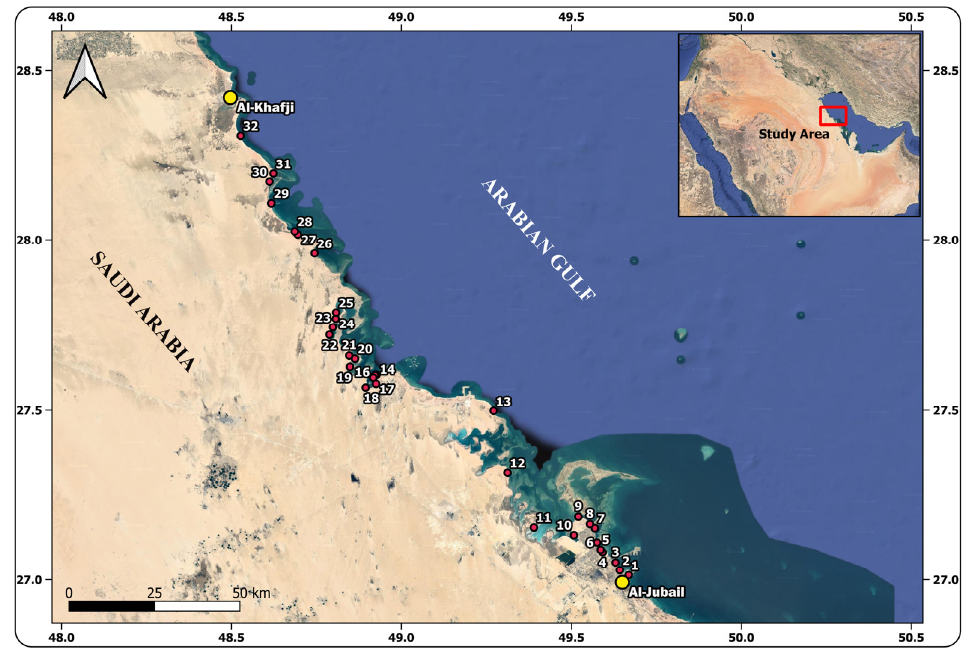
Figure 1. Location of the study area and sample sites along the Arabian Gulf coast.